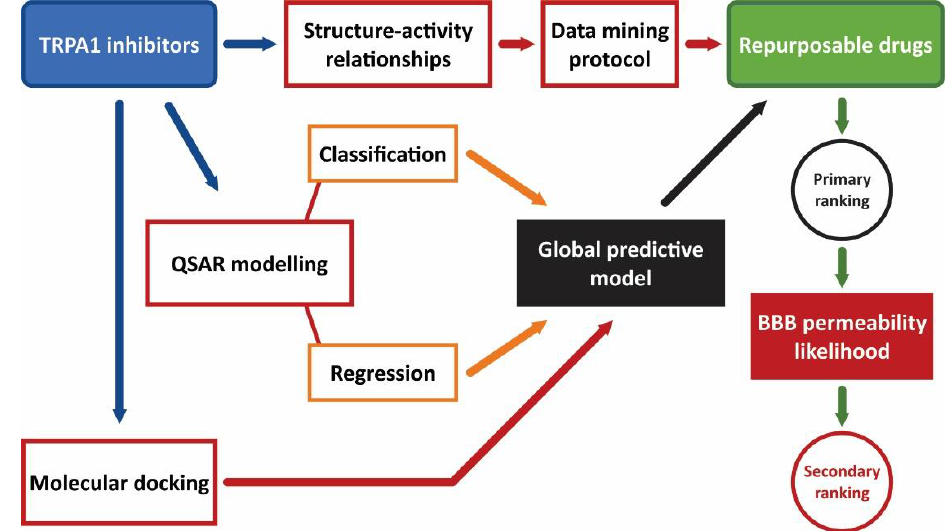
Figure 1. Virtual screening algorithm for discovery of novel potential TRPA1 antagonists.